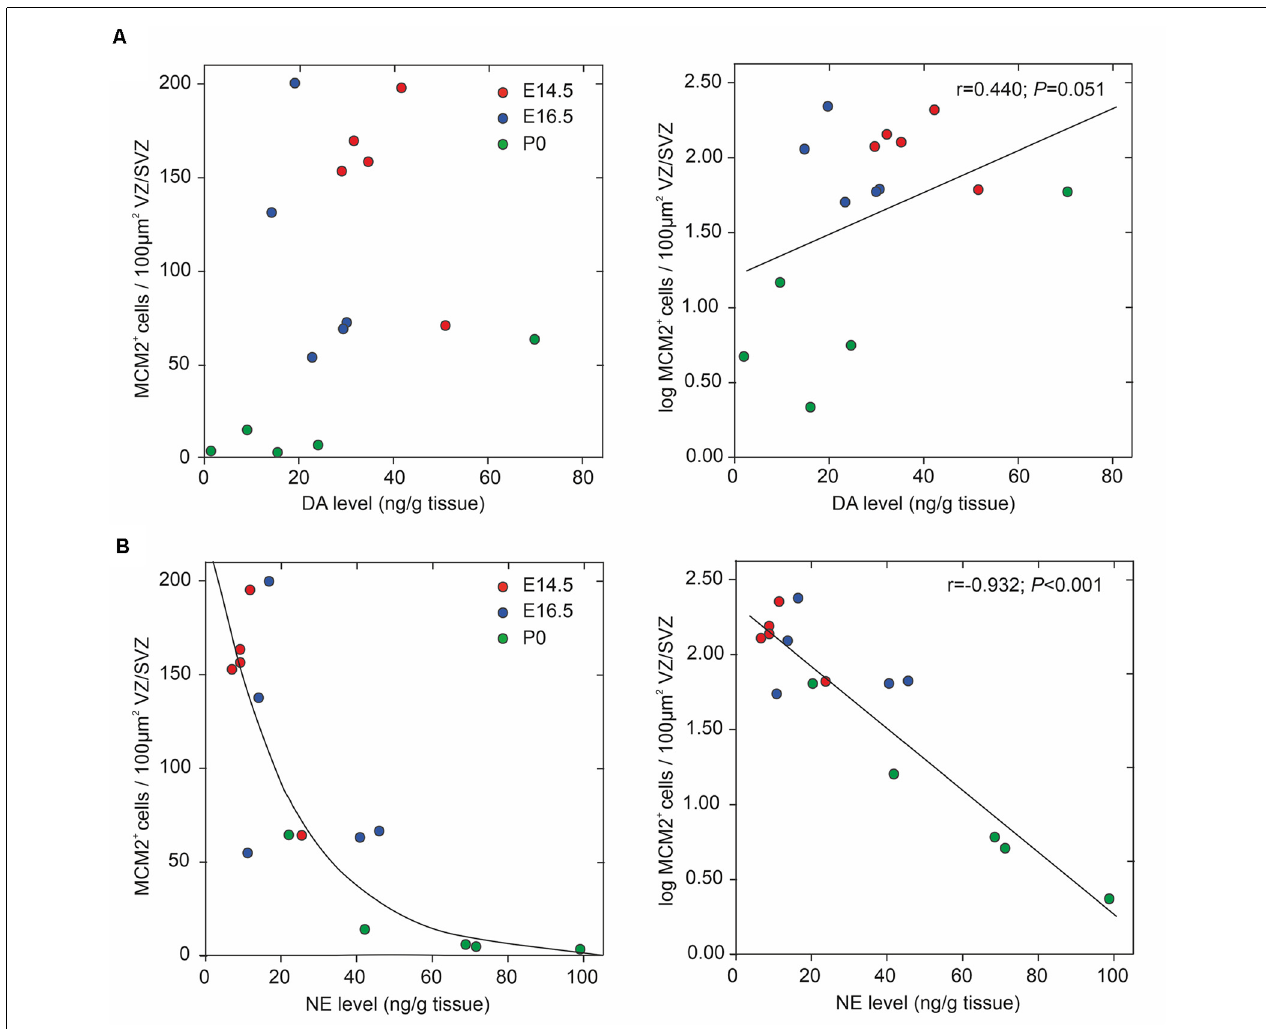
FIGURE 4 | Correlation between periventricular catecholamine levels and neural stem/progenitor cells (NPC) proliferation in VZ/SVZ regions (at developmental stages E14.5, E16.5, and P0). NPC proliferation rate was estimated by quantitative MCM2 immunohistochemistry and DA levels (A) and NE levels (B) , respectively, were measured in microdissected VZ/SVZ regions using HPLC with electrochemical detection. Pearson correlation tests revealed correlations with a magnitude greater than |0.5| of log-transformed MCM2 + cell counts with NE levels, but not with DA levels ( r = 0.440; p = 0.051). The Pearson correlation coefficients for the respective variables are displayed in the upper right part of the graphs. Multiple linear regression model analysis revealed that log-transformed MCM2 + cell counts were significantly associated only with NE levels (corrected r 2 = 0.858, β = − 0.701, p = 0.003), but not with DA levels ( β = 0.045, p = 0.694), embryonic stage ( β = − 0.264, p = 0.137) or brain region ( β = − 0.053, p =